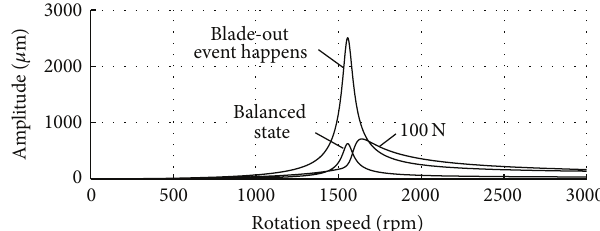
Figure 7: The amplitude-frequency diagram of the rotor when blade-out event